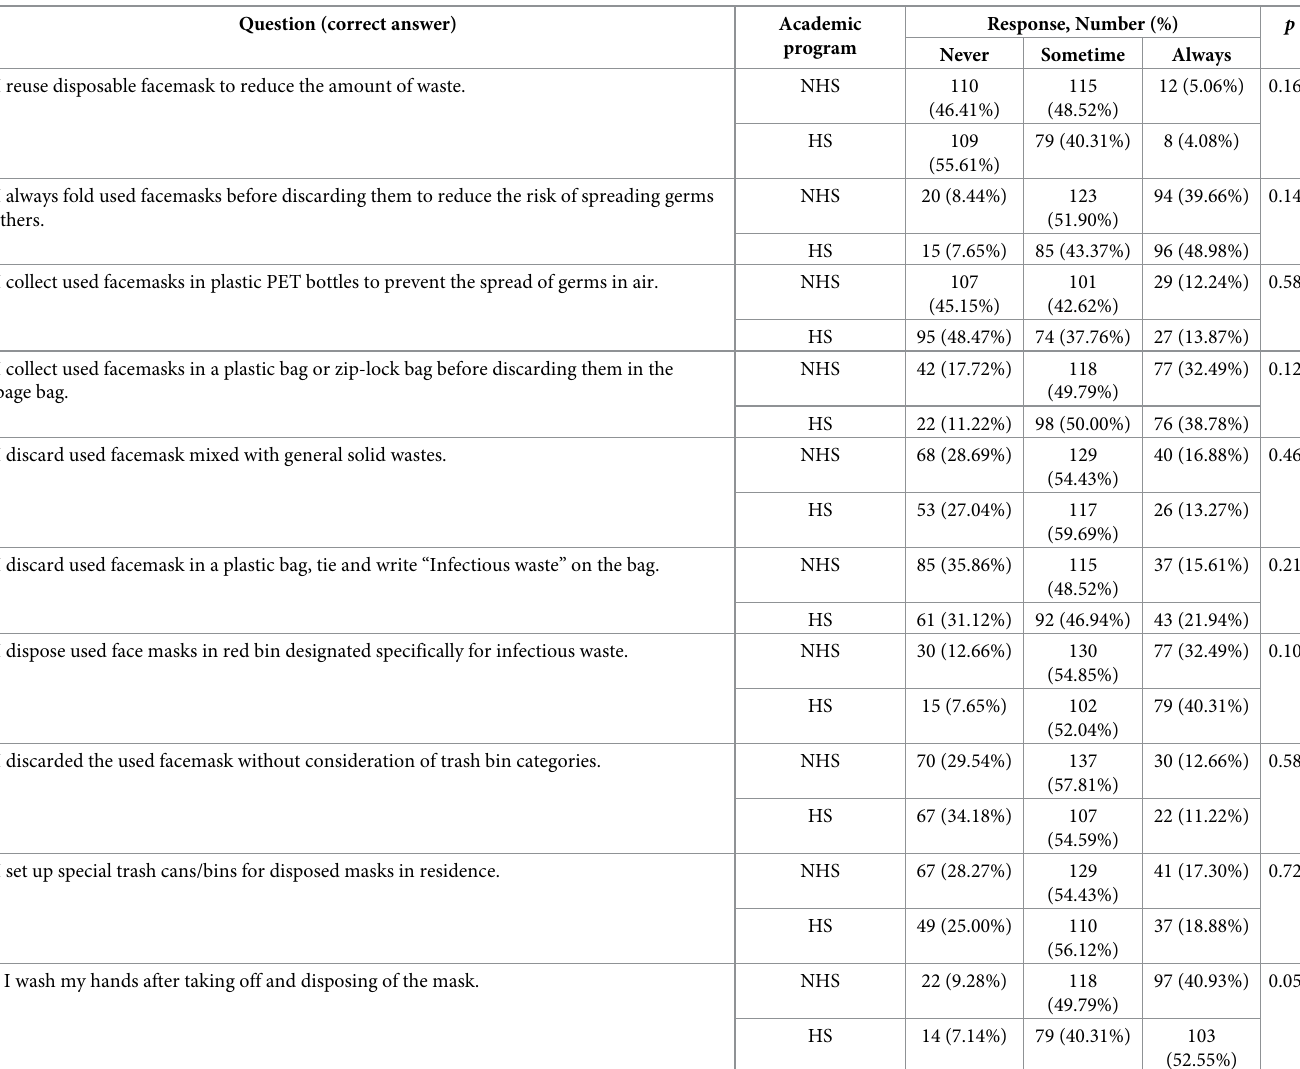
Table 4. Facemask disposal practices among the HS and NHS students (N = 433). Question (correct answer)